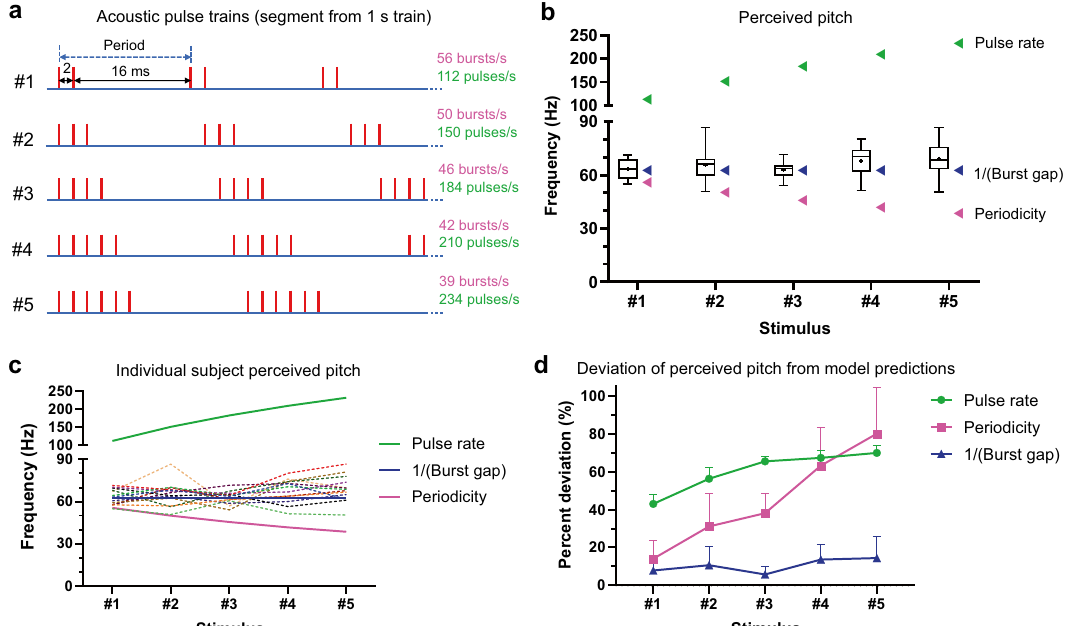
Figure 2. Schematic representation of stimulus patterns and the respective stimulus perceived frequency or pitch obtained in psychophysical tests. ( a ) Acoustic pulse trains with periodic bursts of 2–6 pulses, individual pulses spaced 2 ms apart. Each red vertical line indicates an auditory pulse. The stimuli had their own mean spike rate and burst rate, but the interval between successive bursts in every train was fixed at 16 ms. ( b ) Boxplots with whiskers represent the point of subjective equality (PSE) values obtained in psychophysical experiments for the corresponding stimulus illustrated in panel ( a ) (n = 13). The box extends from 25 to 75th percentiles; the whiskers extend to the minimum and maximum values. A dot within each box indicates a mean PSE (n = 13) value. Arrowheads indicate predicted PSE values for each pulse train if judgments were based on pulse rate (green arrowheads), periodicity/burst rate (pink arrowheads), and reciprocal of the inter-burst interval (1/Burst gap, blue arrowheads). ( c ) Individual subjects’ PSE values represented by dashed lines, solid lines indicate rate and periodicity predicted PSE values for each stimulus. ( d ) Deviation of subjects’ PSEs (n = 13) for each test stimulus from its rate, periodicity and burst gap predicted values, expressed as a percentage of the predicted value. Each data point represents mean and